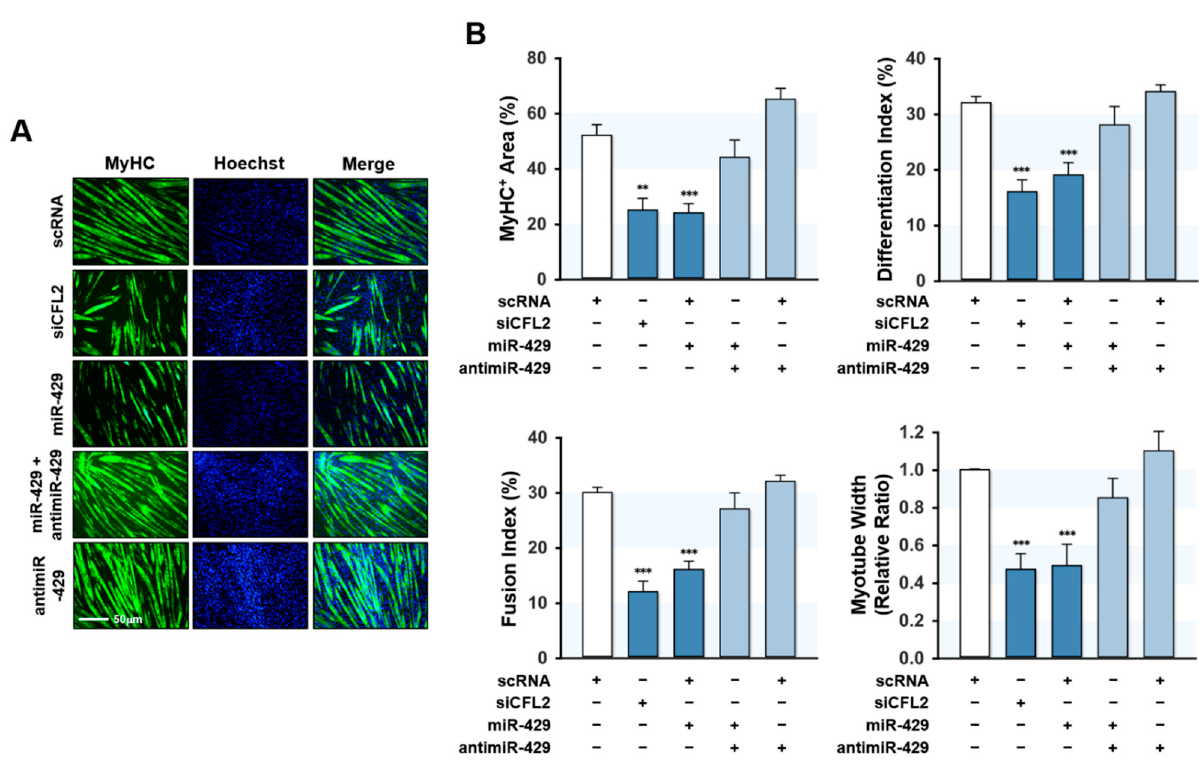
Figure 6. MiR-429-3p mimic impaired myogenic differentiation and myotube formation. After transfection with scRNA control, siCFL2, miR-429-3p mimic, or antimiR-429-3p (200 μ M) for 24 h, C2C12 myoblasts were differentiated for five days. ( A ) MyHC (green)-positive myotubes were obtained by immunofluorescence staining, and nuclei were counterstained with Hoechst (blue). Scale bar: 50 μ m. ( B ), MyHC-positive area, differentiation index, fusion index, and myotube width were determined as described in the Methods section. All results presented are means ± SEM (n > 3), and levels of significance are indicated by ** p < 0.01; *** p < 0.001 vs. scRNA.